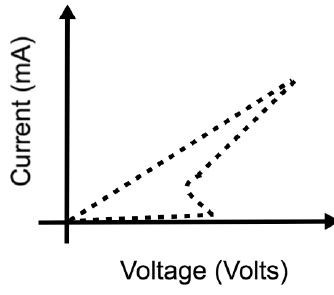
Figure A1. Current–Voltage diagram typical of a phase change materials (PCM) memory storage. The sharp transition at low currents and at a typical “Critical voltage” is clearly